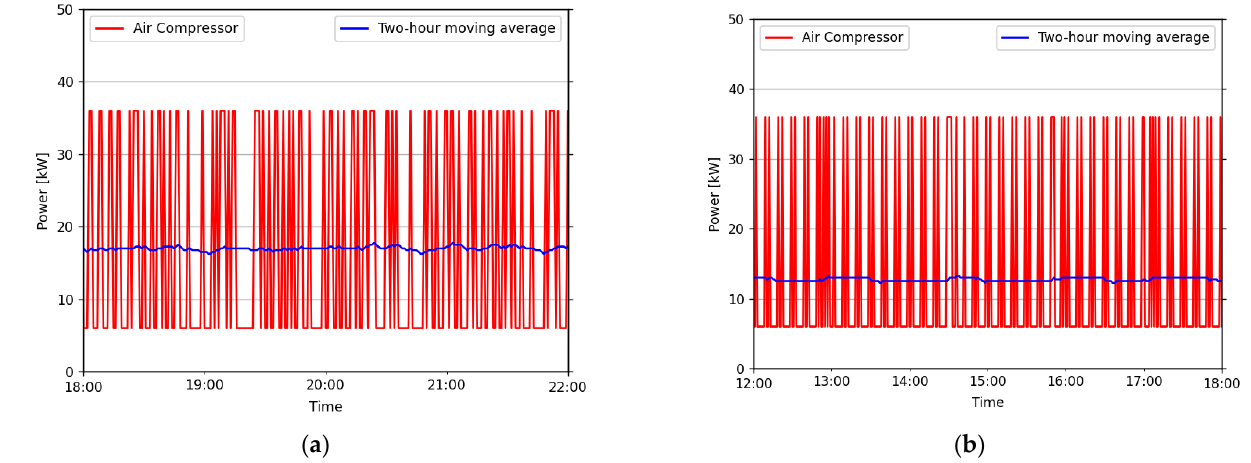
Figure 7. Zoom in in the power data for the Air Compressor, ( a ) Training Period on 19 January, ( b ) Test Period on 18 May.